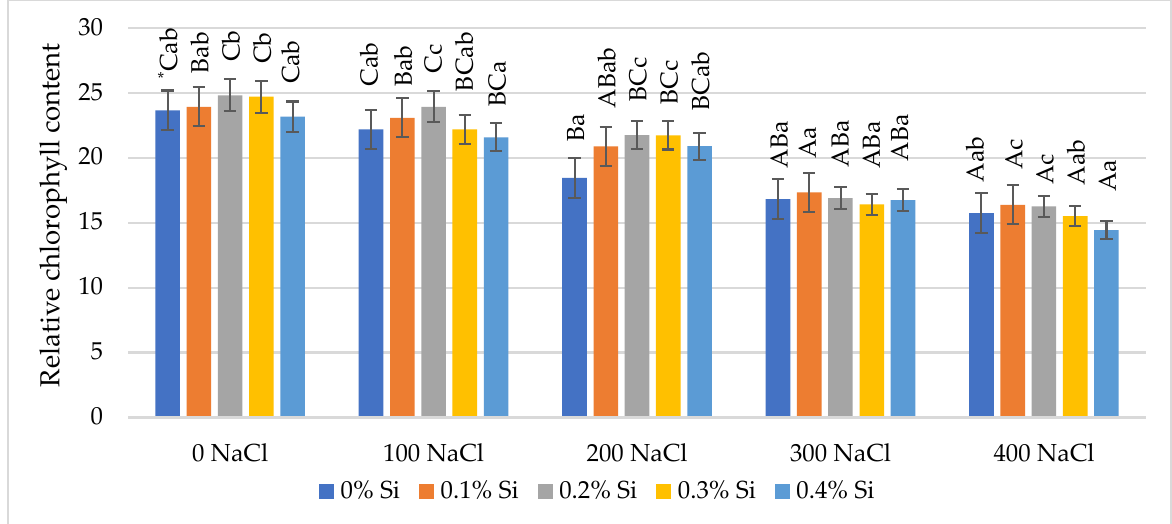
Figure 1. The effect of Si on relative chlorophyll content in maize leaves grown under varied salinity levels. * Capital letters represent significant differences between the averages for soil salinity at the same doses of Si; lowercase letters represent the mean significant differences between the doses of Si at the same salinity ( p = 0.05).